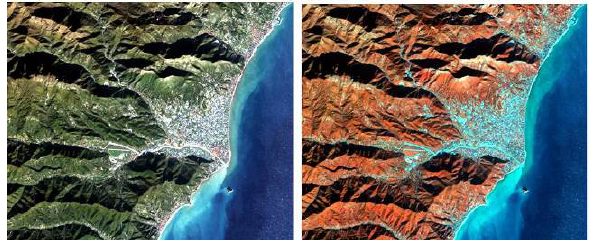
Figure 1. Town of Albenga and delta of Centa River on Nov 29th, 2016: (left) Red – Green – Blue (RGB) true colour composite i.e. the band combination that corresponds to the human vision; and (right) in NIR – green – blue pseudo colour composite that enhances the presence of vegetation (in red).